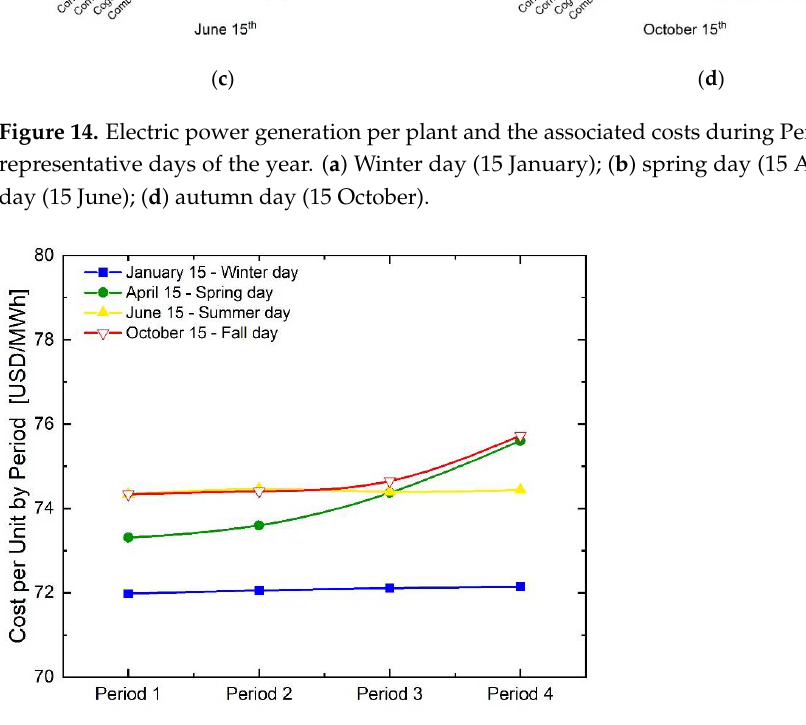
Figure 15. Cost per unit of the electricity generated per period in USD/MWh.